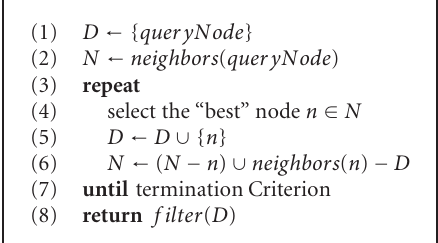
Algorithm 1: Scheme of traditional local-community detection